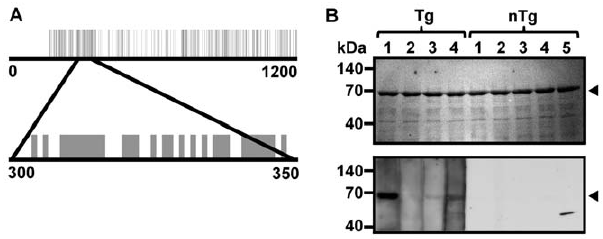
Figure 6. Serologic Responses to Recombinant BT4357 SusC Homolog in B. theta Monoassociated Rats. (A) Amino acid sequence alignment of BT4357 and B. caccae OmpW using Clustal W2, including a magnified view from residues 300–350. Vertical lines represent identical residues. (B) Ponceau S stained Western Blot membrane demonstrating equivalent amounts of purified recombinant BT4357 fragment in each lane (top panel). Western Blot of strips of the membrane shown in the top panel using sera from individual B. theta monoassociated transgenic (Tg) and non-transgenic (nTg) rats and an anti-rat IgG secondary antibody (bottom panel). Predicted size of BT4357 fragment is indicated by the arrowheads.